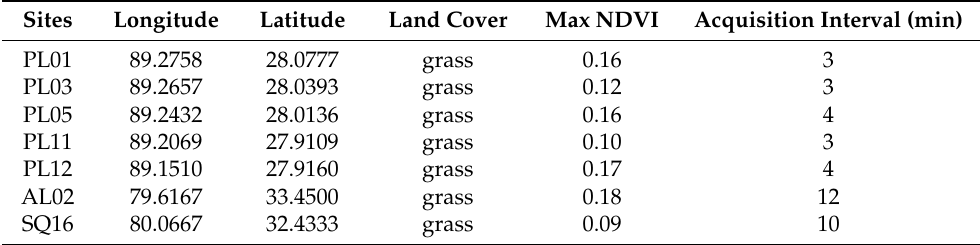
Table 2. Details of the ground